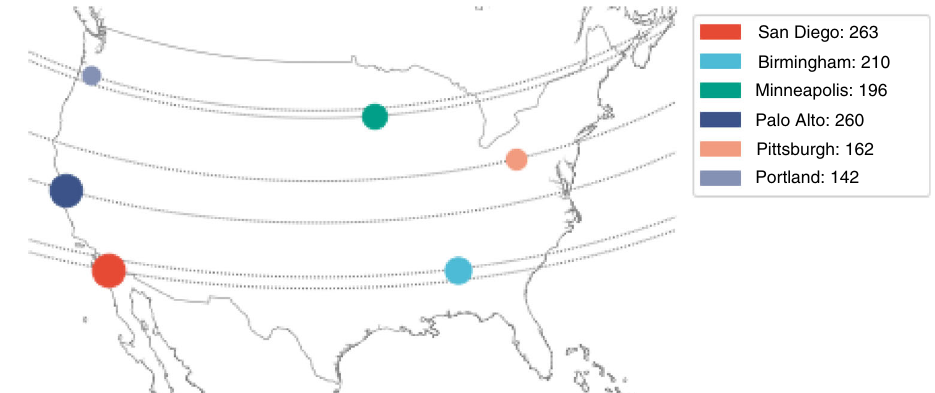
*Data through 2018, demonstrate the number of clear or partially cloudy days (https://www.ncdc.noaa.gov/ghcn/comparative-climatic-data)